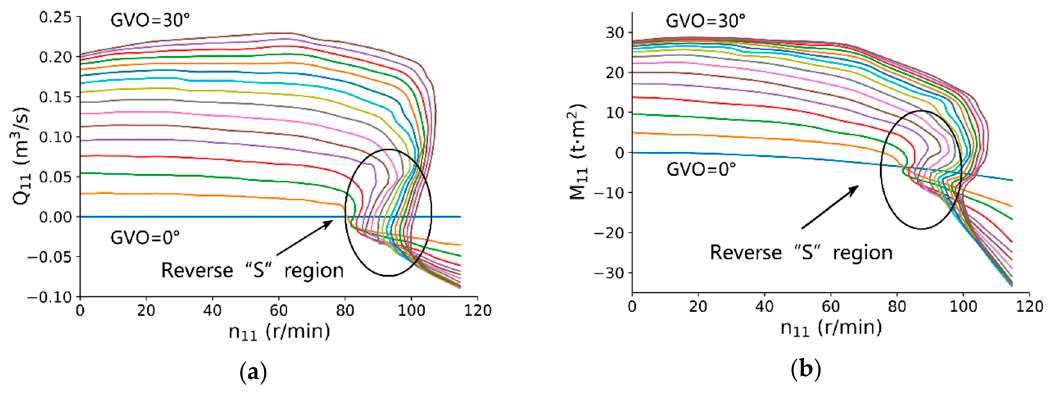
Figure 3. Characteristic curves of pump turbine: ( a ) flow–speed and ( b ) torque–speed.